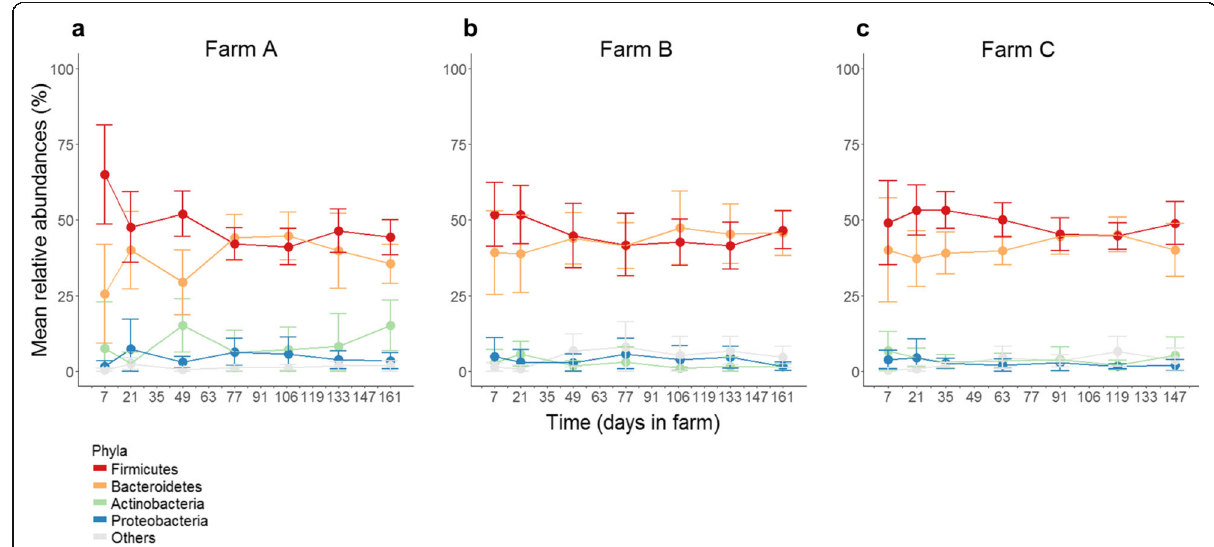
Fig. 3 Mean relative abundance of the four main phyla over time in each farm. The mean relative abundance of the four main phyla on farm A, farm B, and farm C are represented in panels ( a ), ( b ), and ( c ), respectively. The mean relative abundances ± standard deviations of the data are represented by the